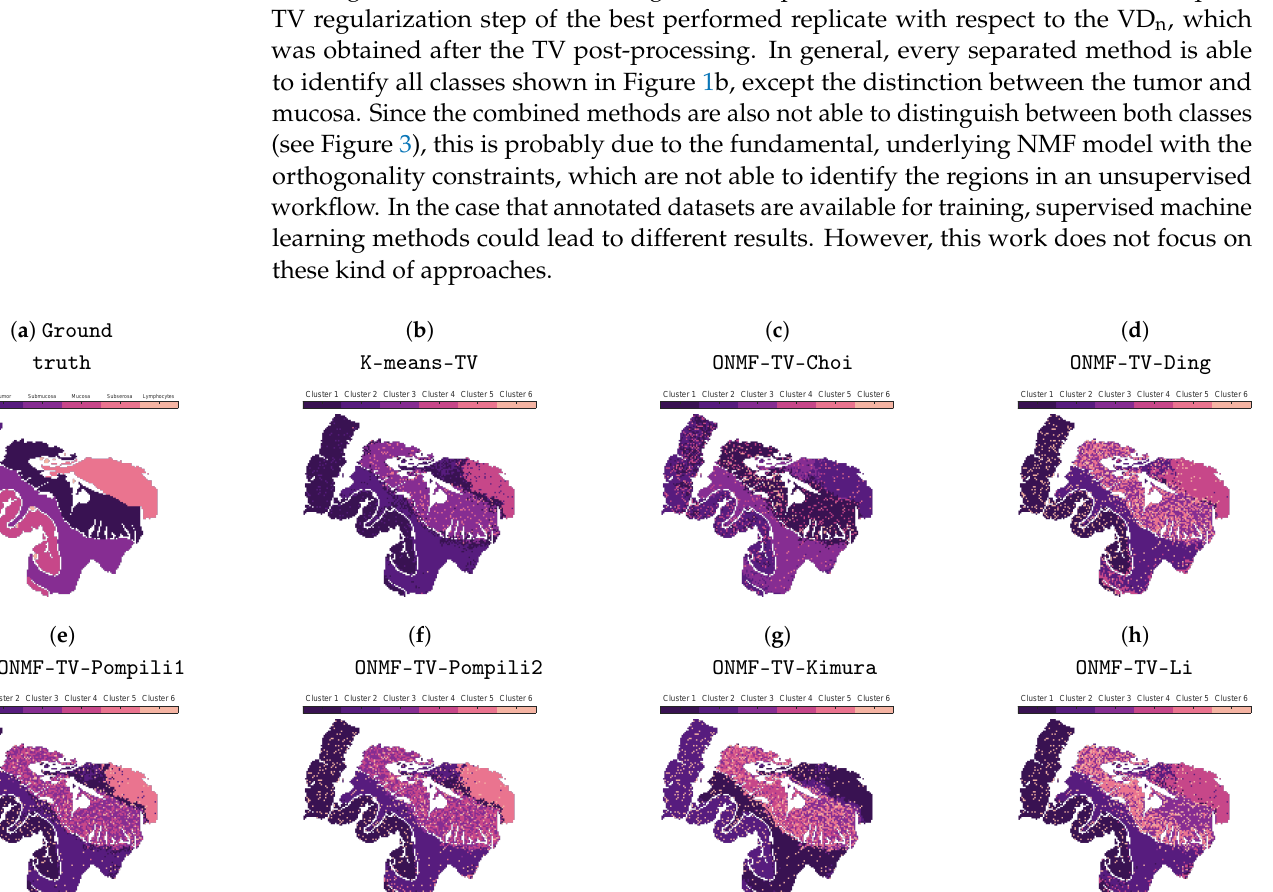
Figure 2. Ground truth and clusterings of all considered separated methods without TV regularization. The best-performing replicate, including the TV regularization, is chosen based on the normalized van Dongen